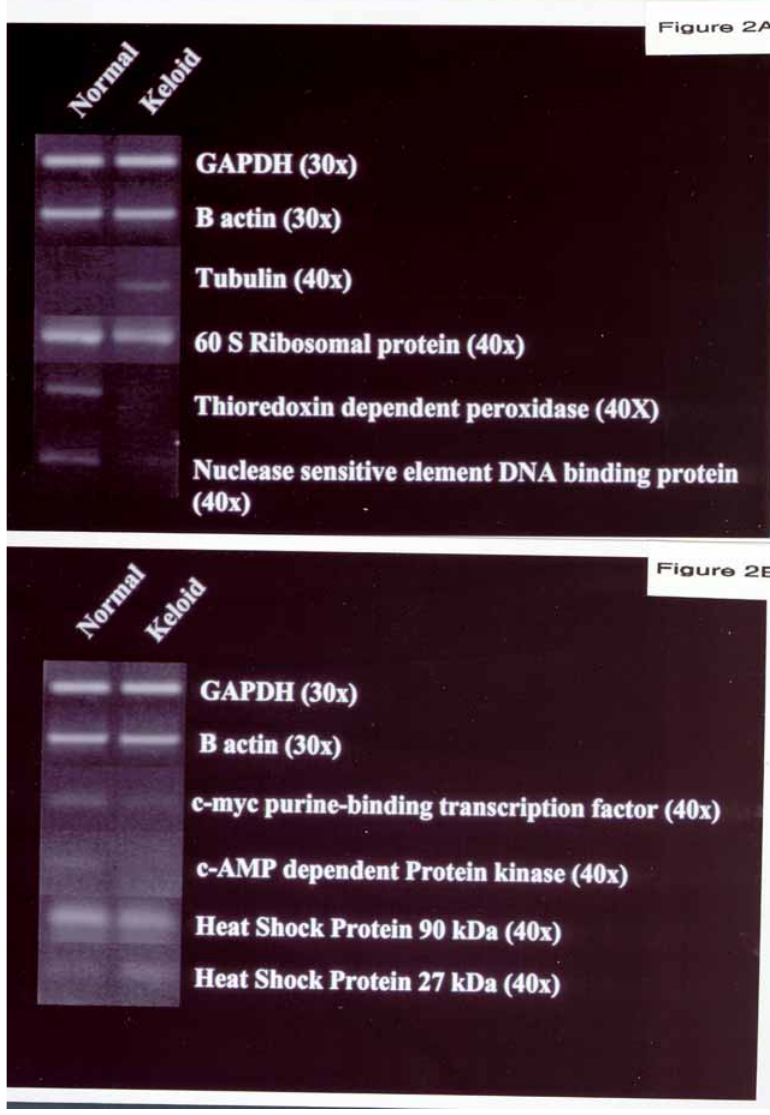
Figure 2. Different effect of keloid and normal dermal fibroblasts on gene expression from positively identified genes in Atlas Array. The genes that were down-regulated in KDF are: 60 S ribosomal protein, DNA binding protein, thioredoxin dependent peroxidase, nuclease sensitive element DNA binding protein, c-myc purine-binding transcription factor, c-AMP dependent protein kinase and HSP 90kDa. The genes that are up-regulated in KDF are tubulin (Fig. 2A), and HSP 27kDa (Fig. 2B). The various genes are compared with GAPDH and β -actin. The primers used are illustrated in Table 1 and the conditions used are described in Materials and